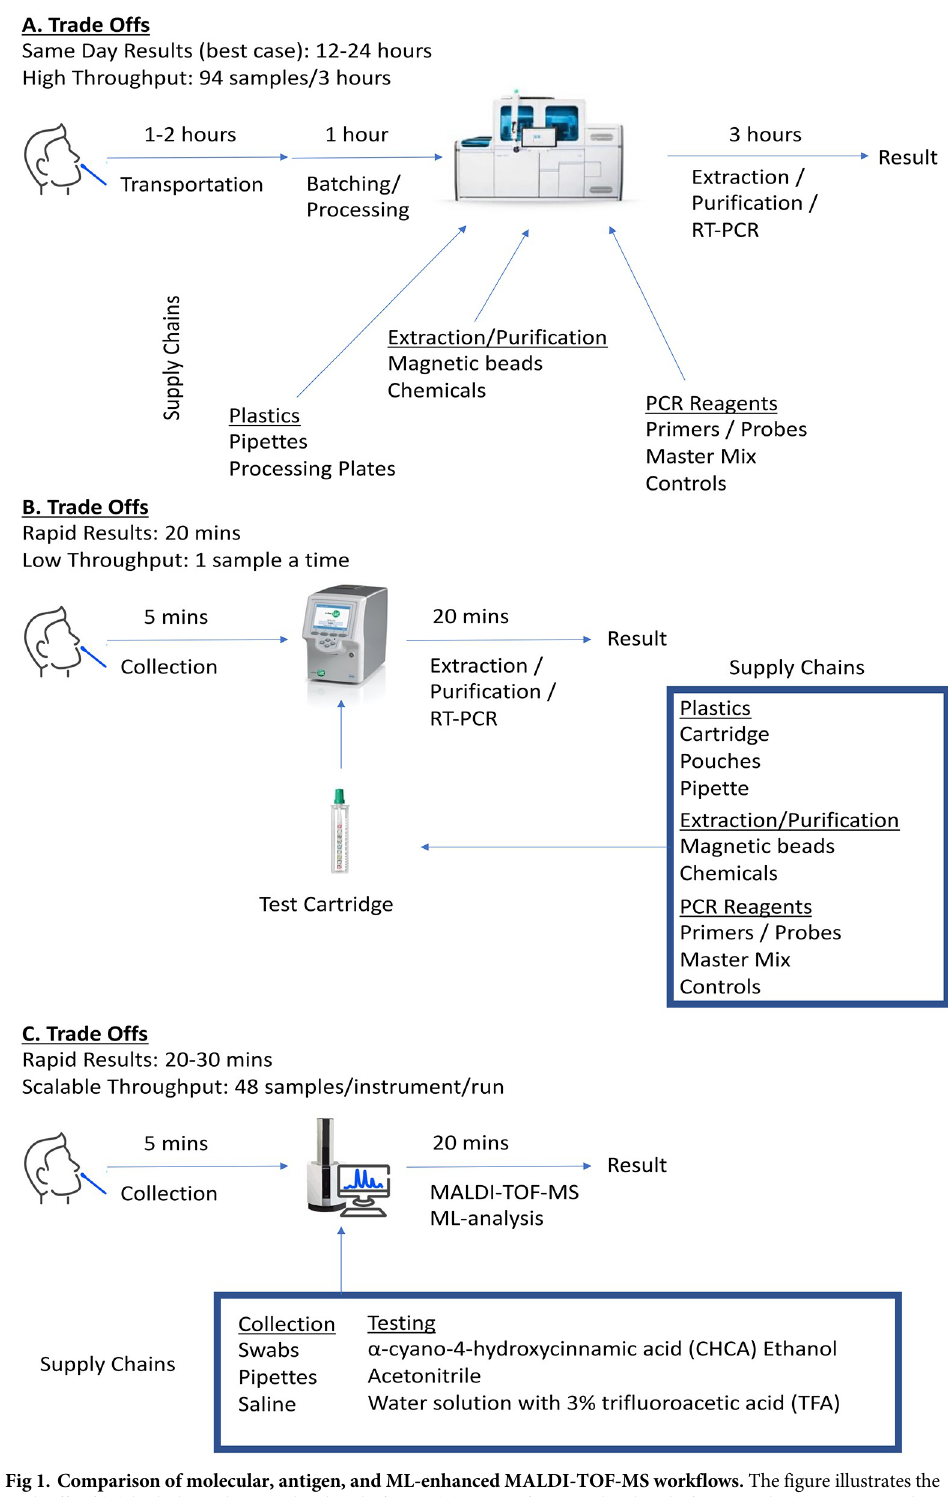
Fig 1. Comparison of molecular, antigen, and ML-enhanced MALDI-TOF-MS workflows. The figure illustrates the tradeoffs of (A) high throughput molecular platforms, (B) point-of-care molecular platforms, and (C) our proposed MALDI-TOF-MS